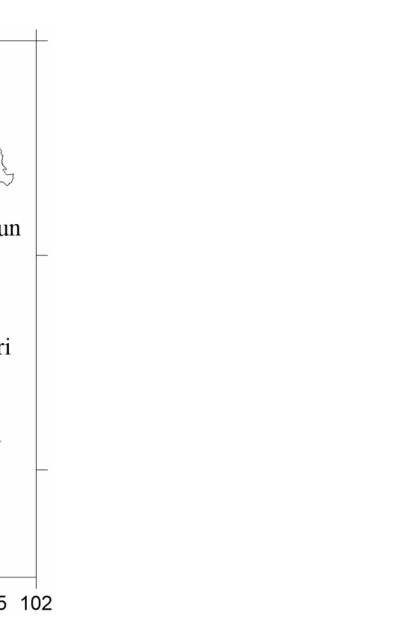
Figure 1. Map showing rice cultivation of Suphan Buri 1 in all six provinces in the central region.